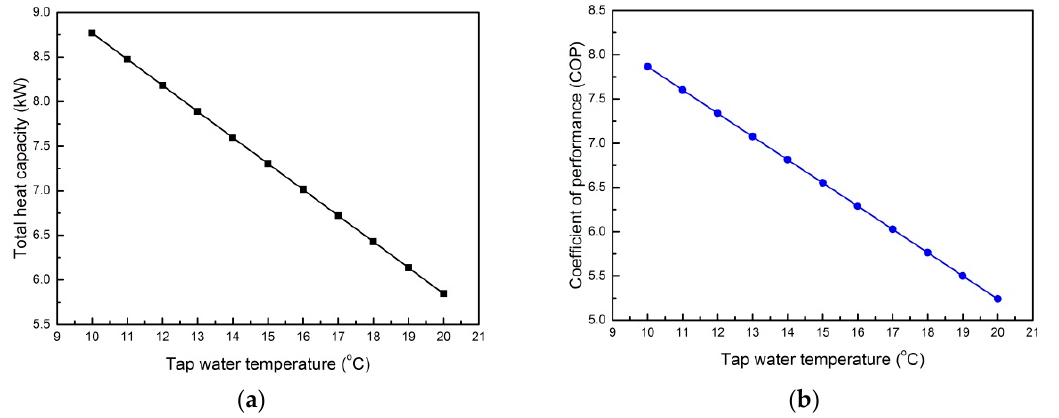
Figure 6. Influence of tap water temperature on total heat capacity and COP: ( a ) Total heat capacity; ( b ) COP.